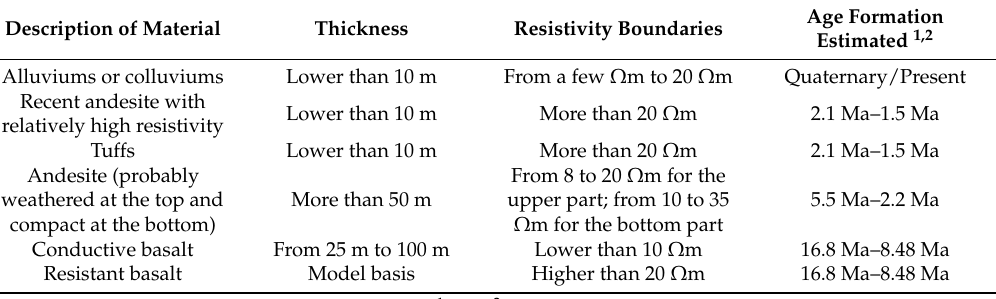
Table 2. Formations identified by field observation, TDEM interpretations and modeled in the 3D geological